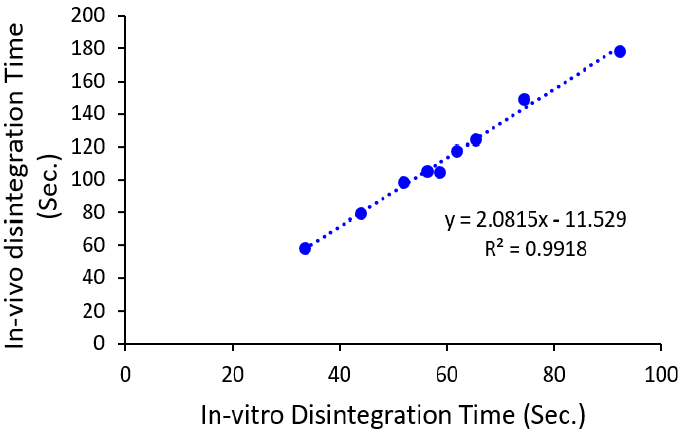
Figure 5. The correlation between in vitro and in vivo disintegration time of all metformin formulations.